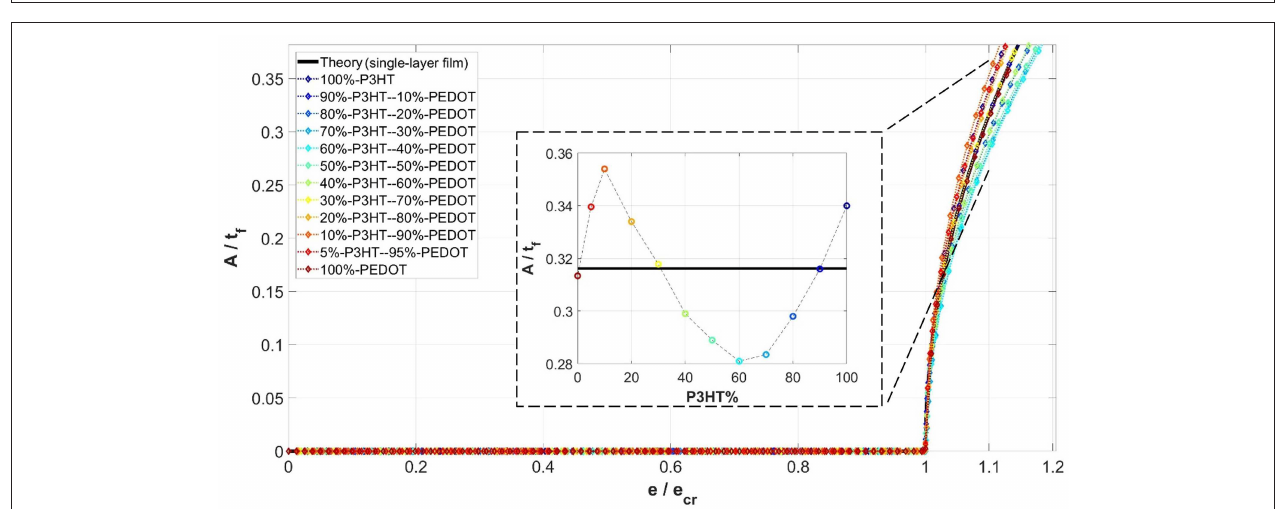
FIGURE 8 | Variations of simulated wrinkling amplitude, normalized by total thickness of the film ( A / t f ), with the progression of normalized applied strain ( e e different fractional volume percentages of the composite films, for the case of generalized plane strain (GPE) under indirect compression. Note that the amplitudes = shown in the inset pertain to e e cr